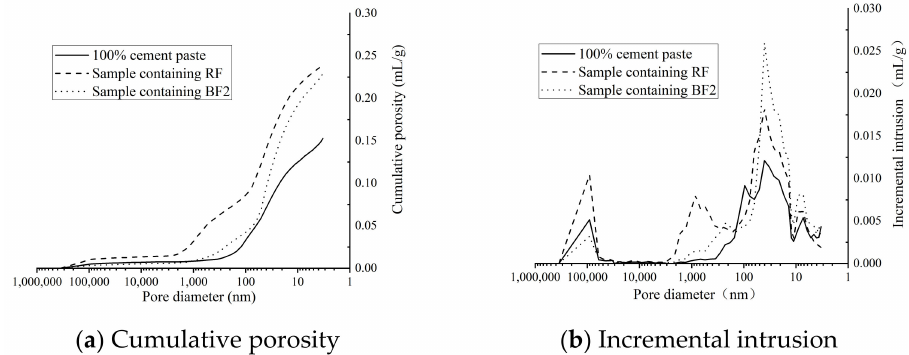
Figure 9. Pore structure of samples containing no, raw and ground fly ash. ( a ) Cumulative porosity. ( b ) Incremental